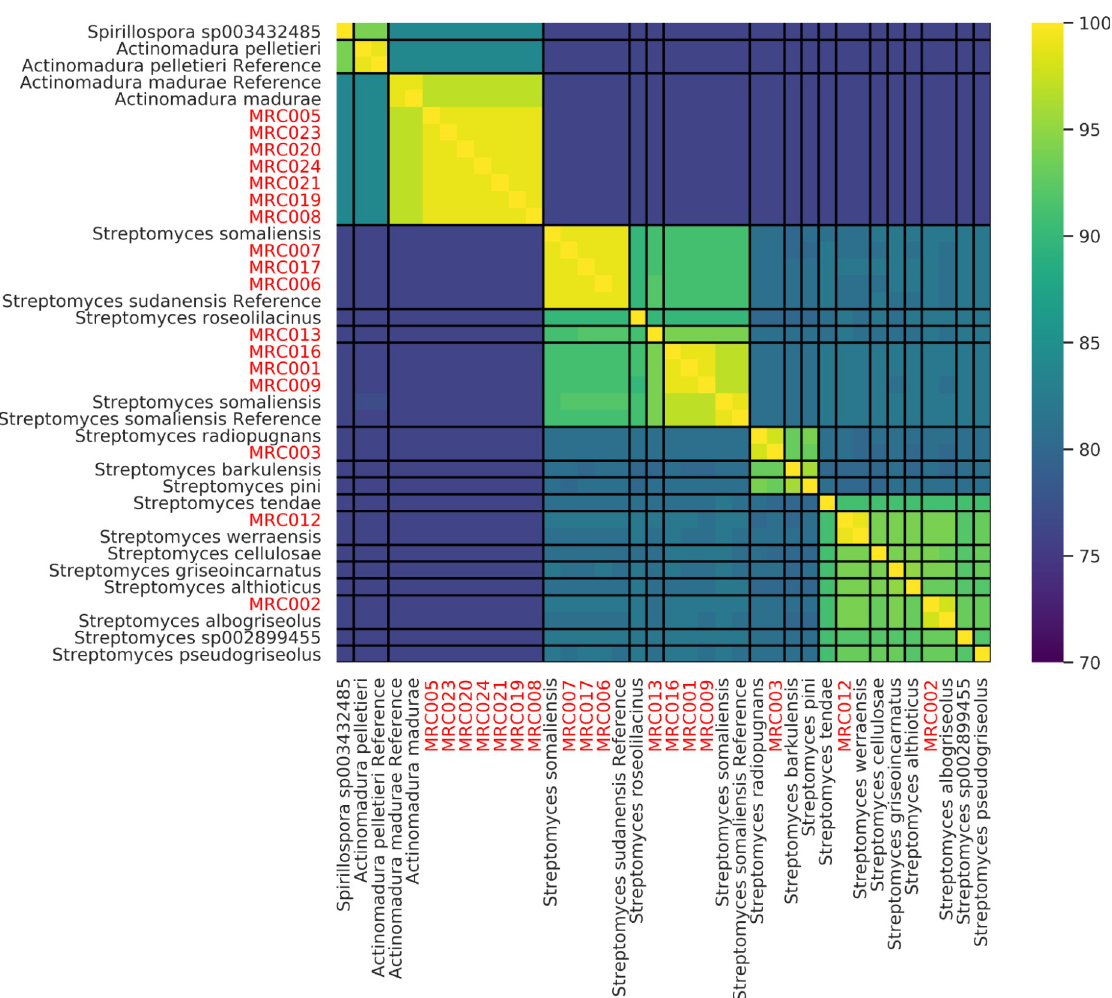
Fig 4. Pairwise comparison of Average Nucleotide Identity between the genomes of Isolates from the Mycetoma Research Centre (red) and their closest relatives in GTDB (all genomes from GTDB with an ANI > 90 with any single isolate genome or the genome of type strains). The heatmap is ordered based on hierarchical clustering (Ward, Euclidean distance). Black lines delineate species boundaries based on ANI > 95%. The genomes of the reference species are from type strains.